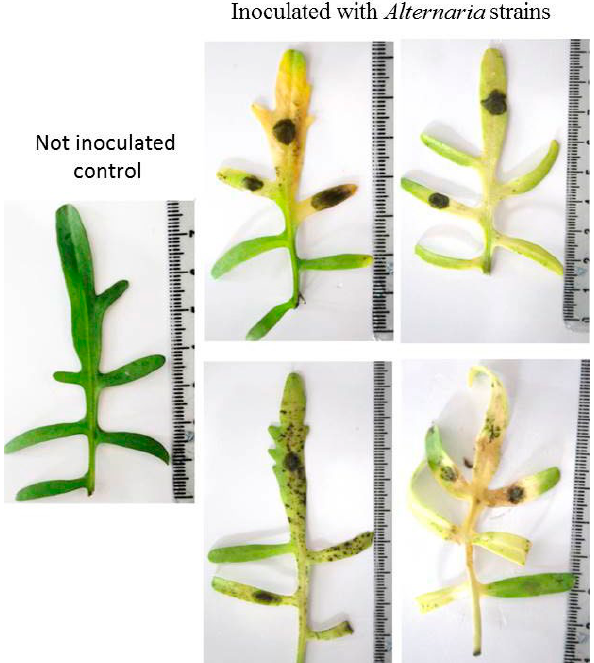
Figure 3. Symptoms resulting on Cakile maritima leaves 7 d after inoculation with Alternaria strains A. alternata (ITEM17830; two upper photographs) or A. mali (ITEM17842; lower photographs).